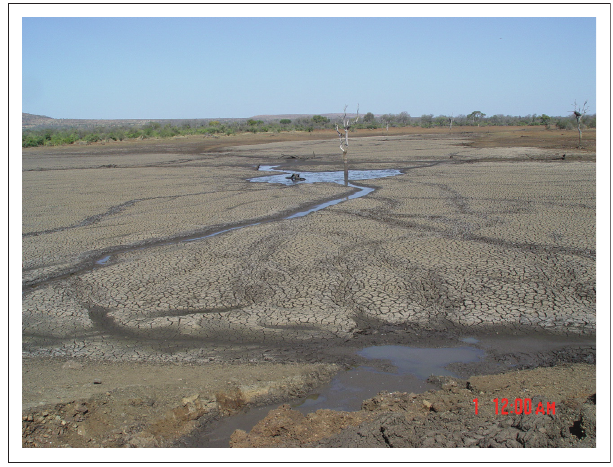
FIGURE 8: Hippopotamus dung-ladened sediment, Nhlanganzwane Dam.